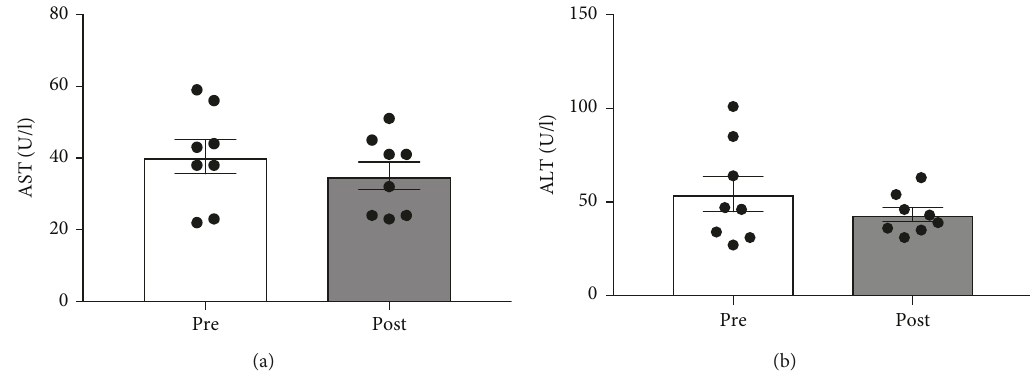
Figure 5: The e ff ect of a 90-day low-carbohydrate diet on plasma AST and ALT in women ( n = 8